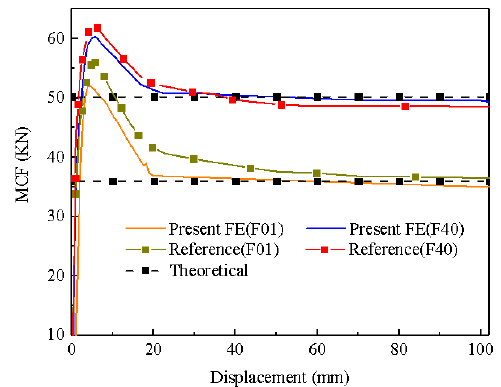
Figure 3. The present FE and reference.